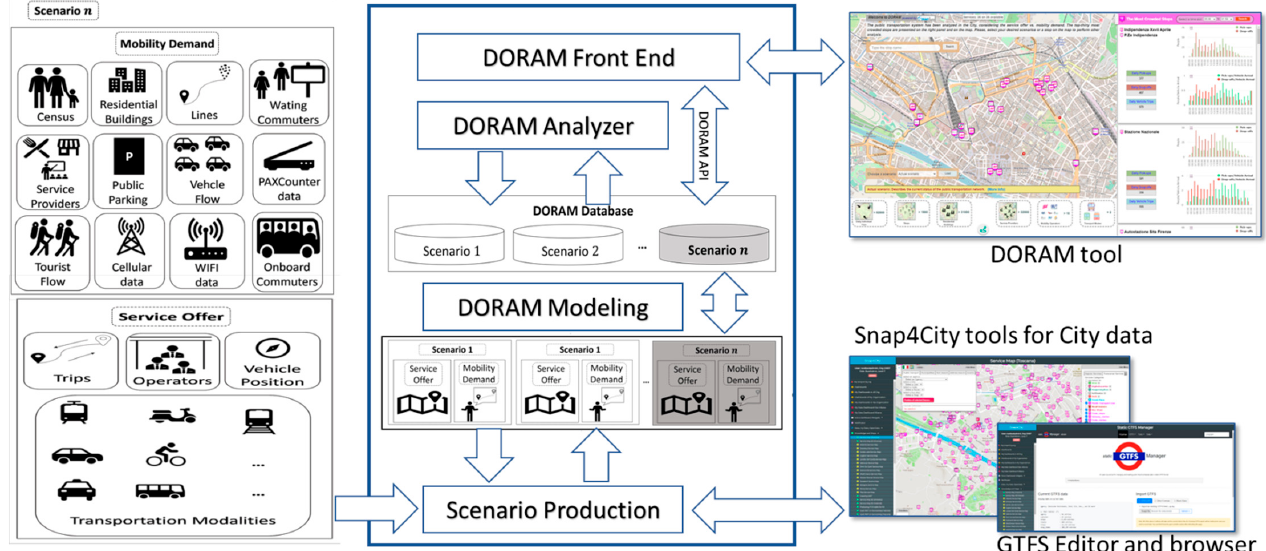
Figure 1. The general DORAM architecture.